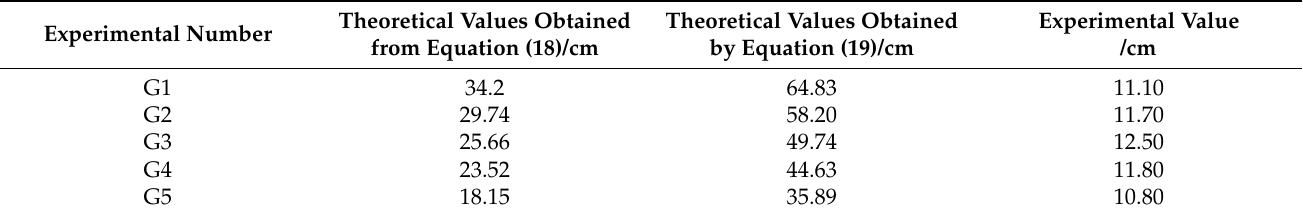
Table 3. Comparison between the experimental results and theoretical calculation